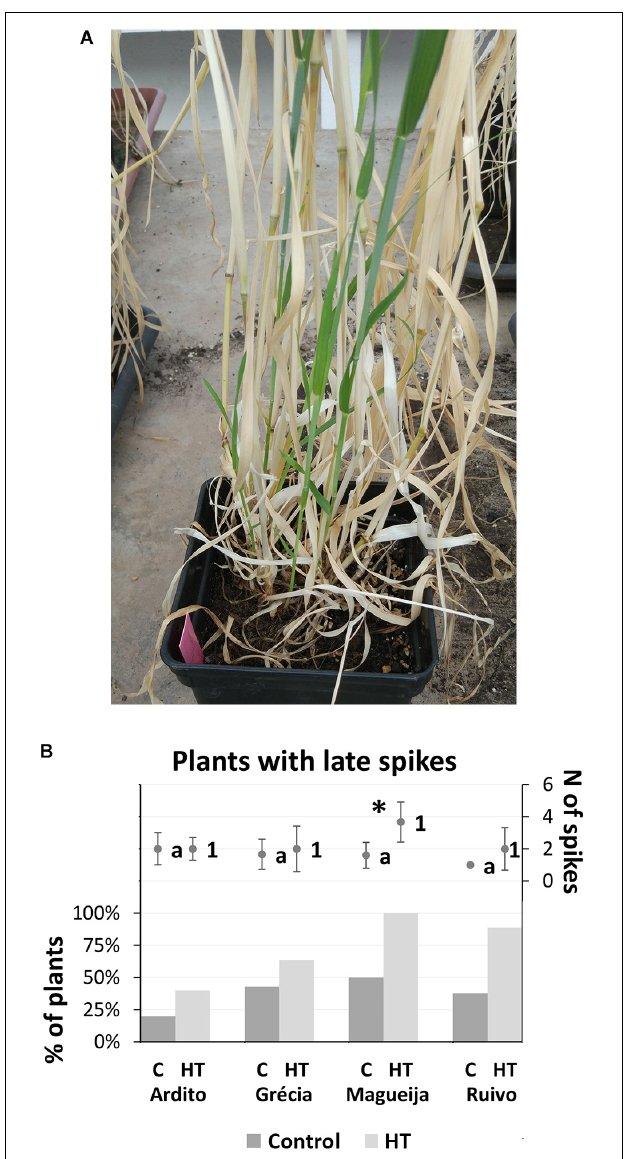
FIGURE 2 | Late spike evaluation. (A) HT-treated plant of Magueija landrace presenting four late spikes. (B) Mean number of late spikes per plant in control (dark gray dots) and HT treated (light gray dots) plants ± standard deviation (represented as bars) and percentage of plants with late spikes in control (dark gray columns) and high temperature (HT) conditions (light gray columns). Different letters and numbers next to dots indicate ANOVA significant differences between landraces in both control and treatment conditions, respectively, and *indicates t-test statistical differences between control and treatment in each variety ( p <